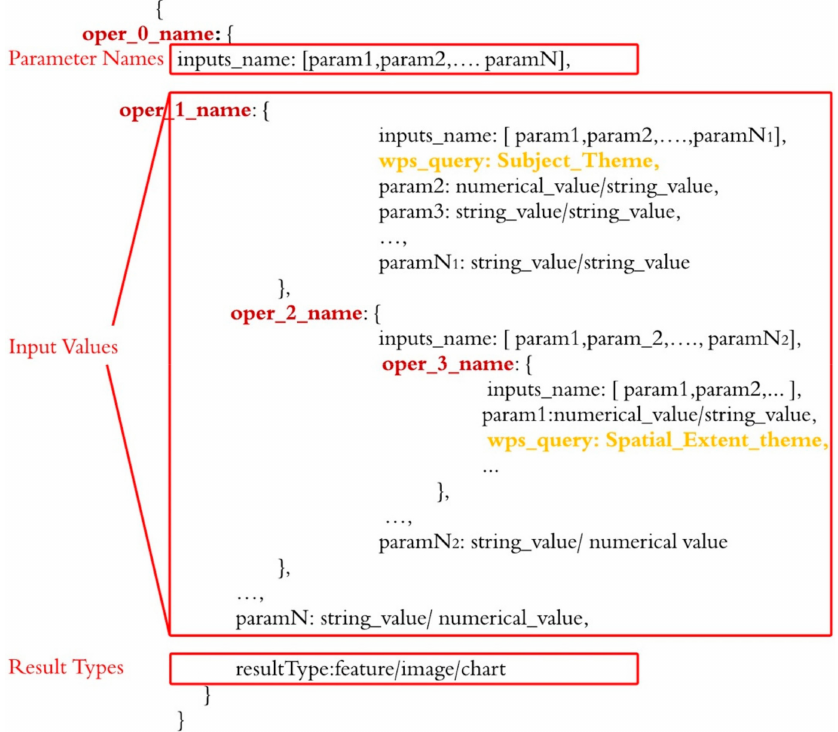
Figure 4. The universal representation of the rule for complex spatiotemporal